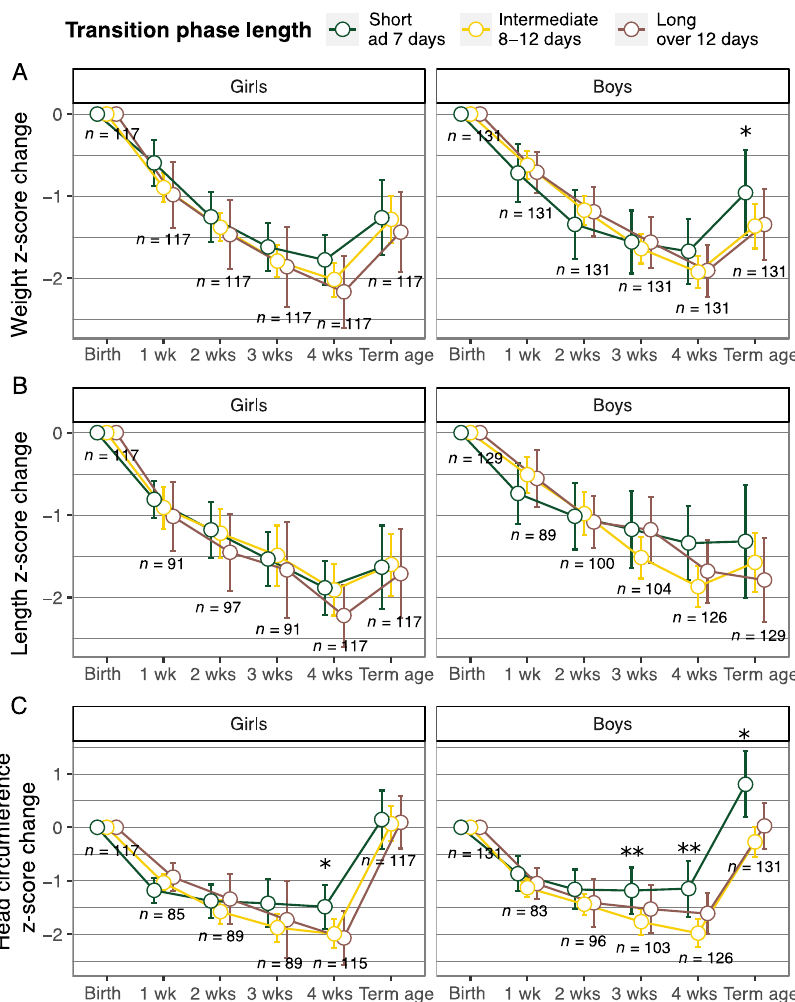
Figure 2. Weight ( A ), length ( B ), and head circumference ( C ) z-score change (mean and 95% confidence interval) from birth to the age of one, two, three, and four weeks, and term equivalent age according to the transition phase length quartiles (intermediate transition corresponding to the second and third quartile). Linear mixed model, adjusted for gestational age at birth and weight, length or head circumference z-score at birth, and head circumference model also for severe (grade III or IV) intraventricular hemorrhage. Short transition length up to 7 days was set as reference level. * p < 0.05 for short vs. intermediate and long transition ** p < 0.05 for short vs. intermediate transition.